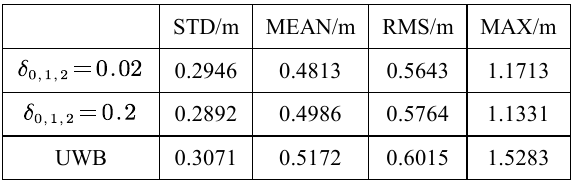
Table 3 . Statistical values of position errors for UWB/INS integration with various measurement